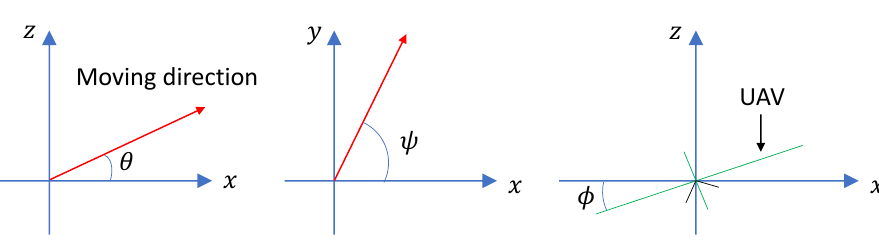
Figure 2. Illustration of the flight path angle θ , the heading angle ψ , and the bank angle φ